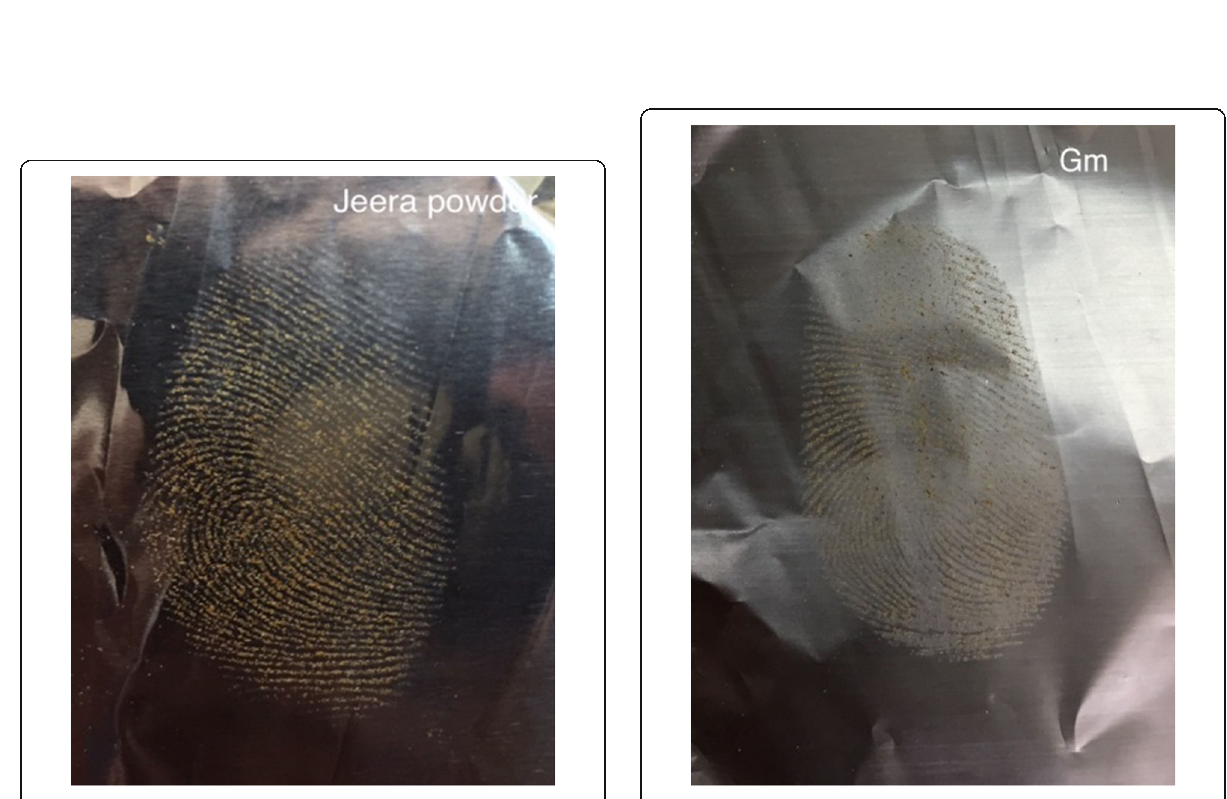
Fig. 13 Development of Latent fingerprint by Red Chilli powder on Aluminum Foil